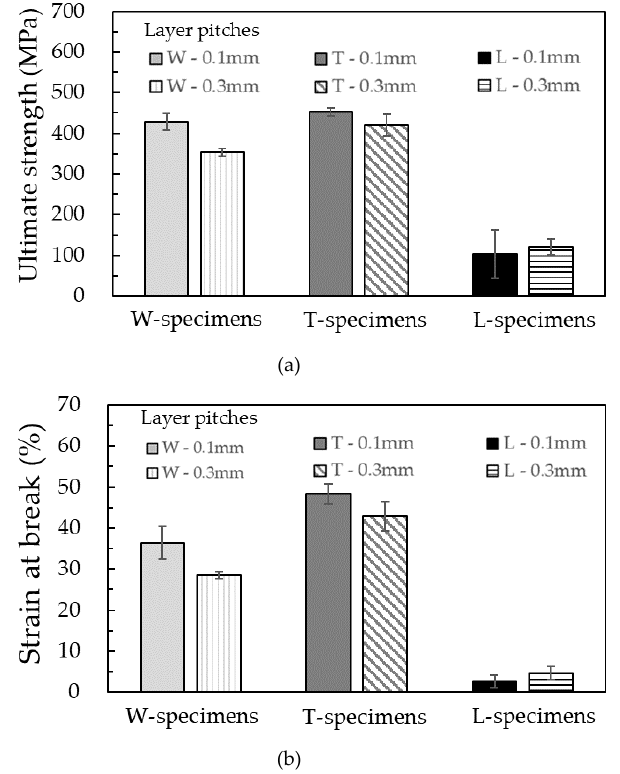
Figure 6. Results of tensile tests. ( a ) Ultimate strength and ( b ) strain at break of the silver parts printed in various layer directions and thicknesses.